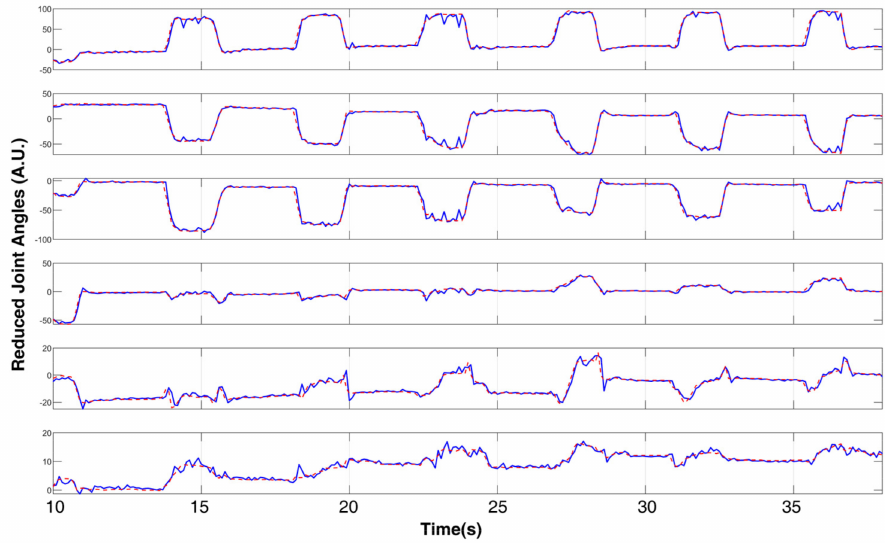
Figure 12. Comparison of NARX outputs and target joint angles in reduced space (all